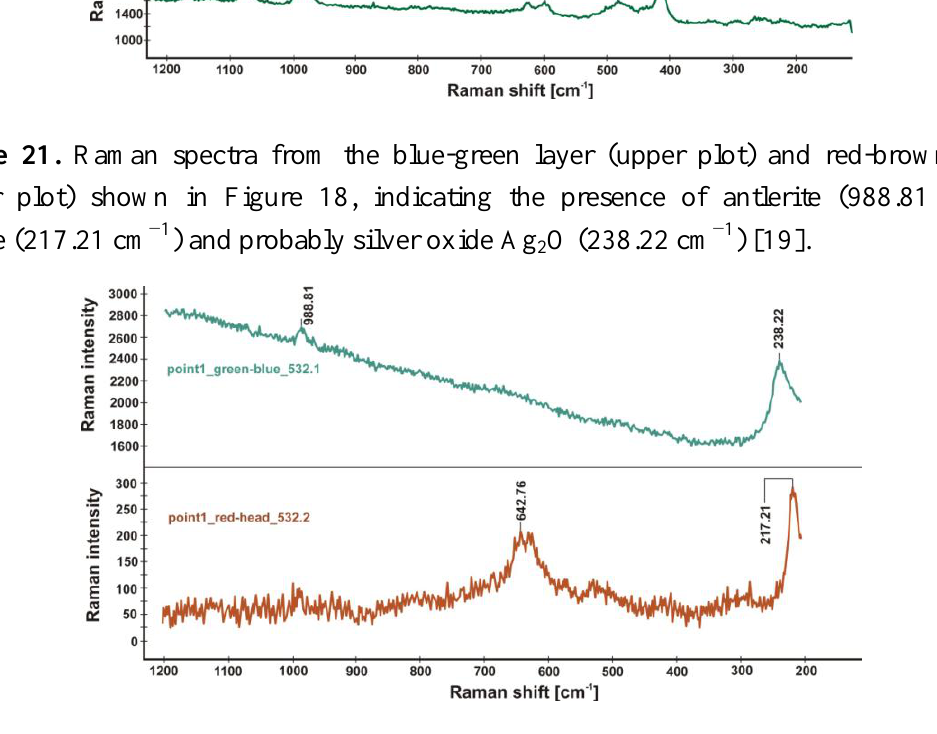
Figure 22. Raman spectra from the red layer (upper plot) and black layer (lower plot) shown in Figure 18, indicating the presence of antlerite (988.81 cm −1 , 417.41 cm −1 ), and probably silver oxide Ag O (239.78 cm −1 , 238.03 cm −1 2